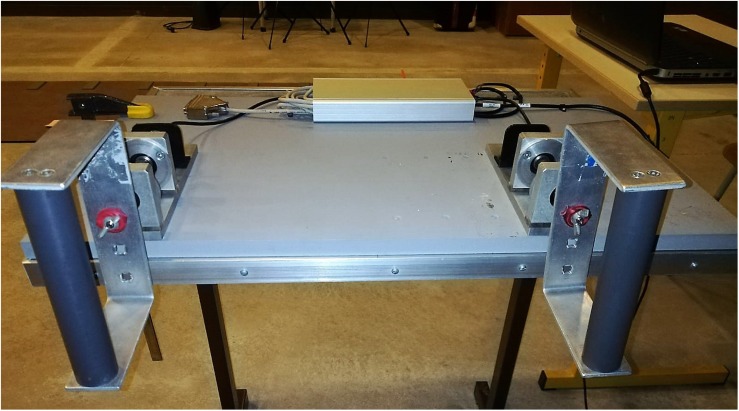
Experimental setup.